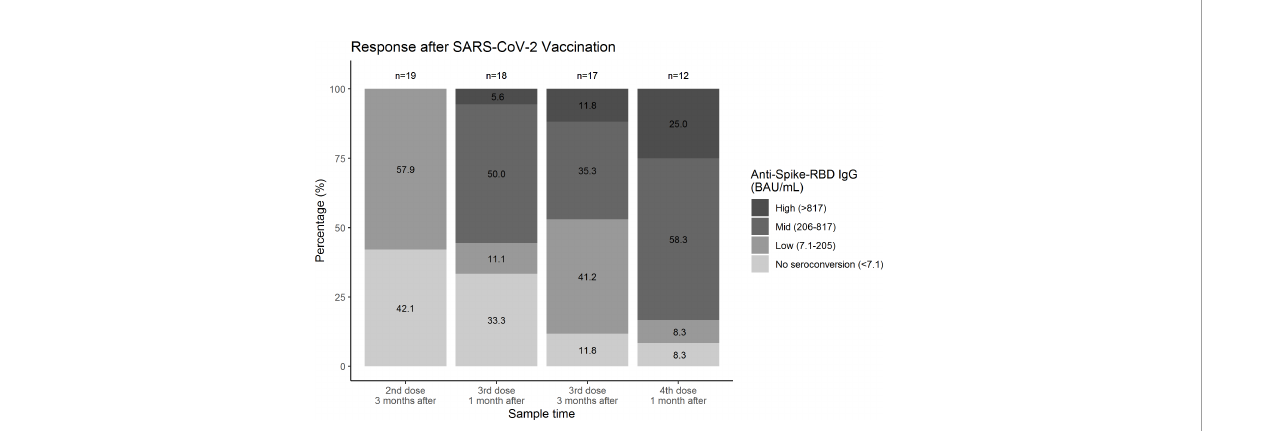
FIGURE 1 Proportion of individuals with common variable immunode fi ciency within each category of anti-spike protein receptor-binding domain IgG antibody response after different doses of SARS-CoV-2 vaccination. Samples were collected from 27 individuals with common variable immunode fi ciency. Samples collected after administration of monoclonal antibodies were excluded. Proportions were compared with McNemar; 3 months after the second and third dose p = 0.248 and 1 month after the third and fourth dose p = 0.480. The number of missing samples in each column (from left to right) were n = 8, n = 9, n = 10, and n = 15, respectively. The missing samples were included in Supplementary Figure 2. RBD, receptor-binding